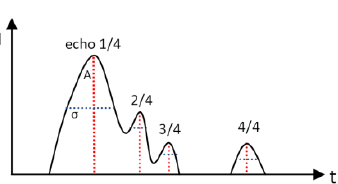
Fig. 1: Backscattered signal recorded by full waveform laser scanner. Gaussians are fitted to the sampled signal. The features amplitude A and width σ can be used to characterise the